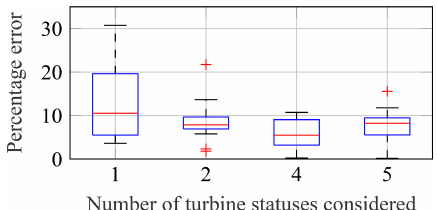
Figure 16. Percentage errors of predicted yearly damage values us- ing simple extrapolation. Data separated according to turbine sta- tuses: no separation (1), normal production operation and others (2), idling below cut-in and above cut-off (4), and service (5).